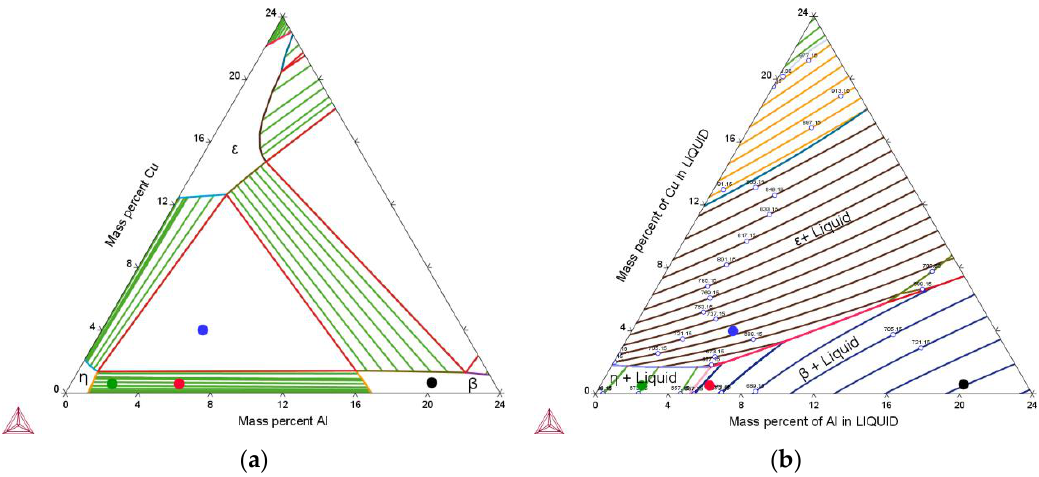
Figure 1. Computed isothermal section at T = 375 °C of the Zn-rich Zn-Al-Cu phase diagram based on the CALPHAD data from [9] ( a ). The four different alloy compositions investigated in this paper are marked by the filled circles. Computed liquidus projection ( b ).